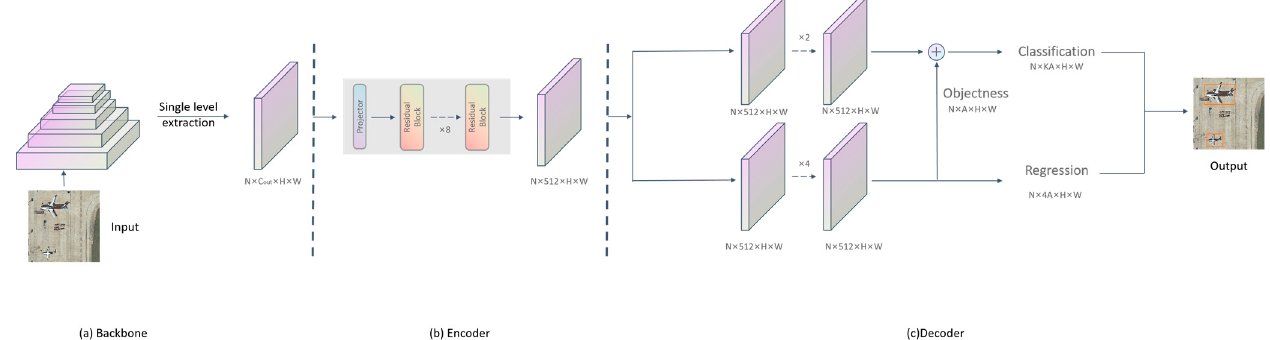
Figure 2. Overall framework of StrMCsDet.